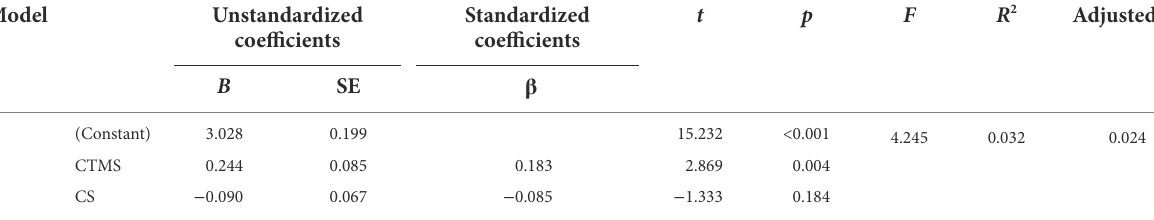
TABLE 4 Multiple regression results of satisfaction with life.